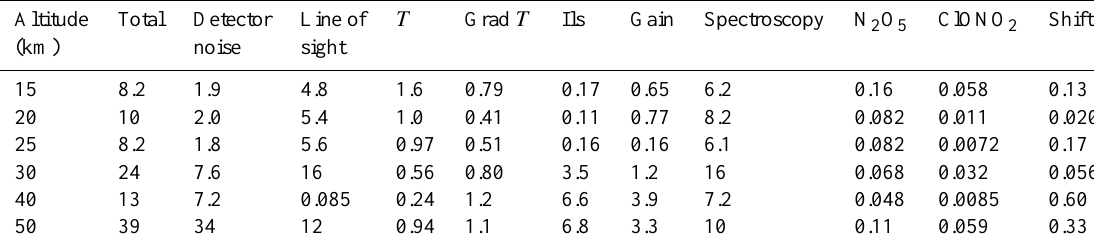
Table 5. As Table 4, but for N 2 O (version V5H_N2O_21). Altitude